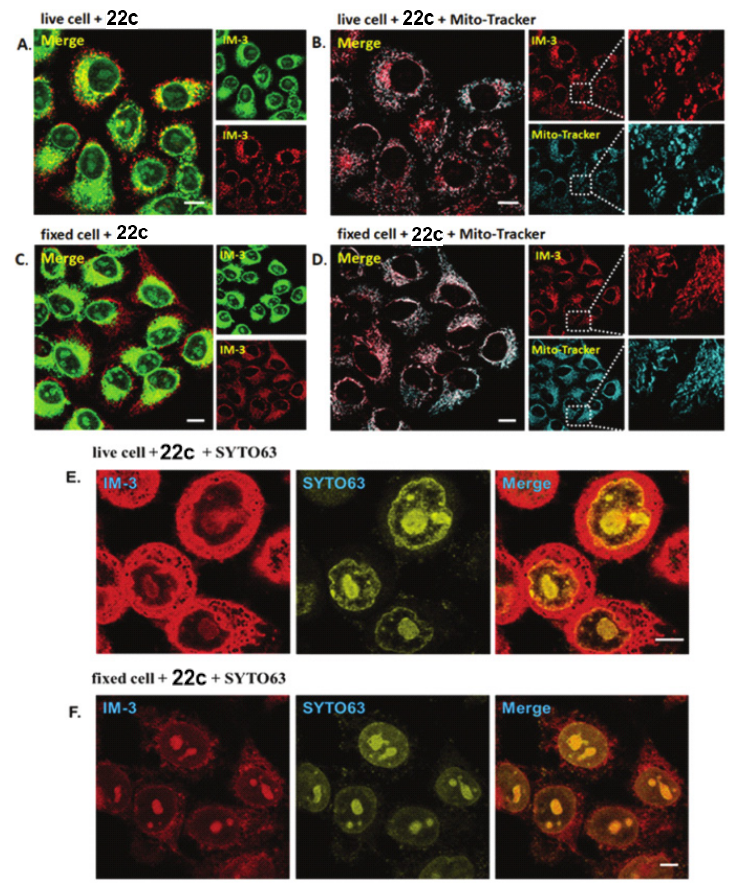
Figure 19. Colocalization experiments of HepG2 cells stained with 22a – c . ( A ) 22c fluorescence (485 nm), ( B ) 22c fluorescence and MitoTracker ® (633 nm), ( C ) fixed HepG2 cells stained with 22c , ( D ) fixed HepG2 cells stained with 22c and MitoTracker ® , and ( E , F ) live and fixed HepG2 cells incubated with 22c and SYTO63 ® (657 nm). Scale bar = 8 μ m. Adapted from [54].